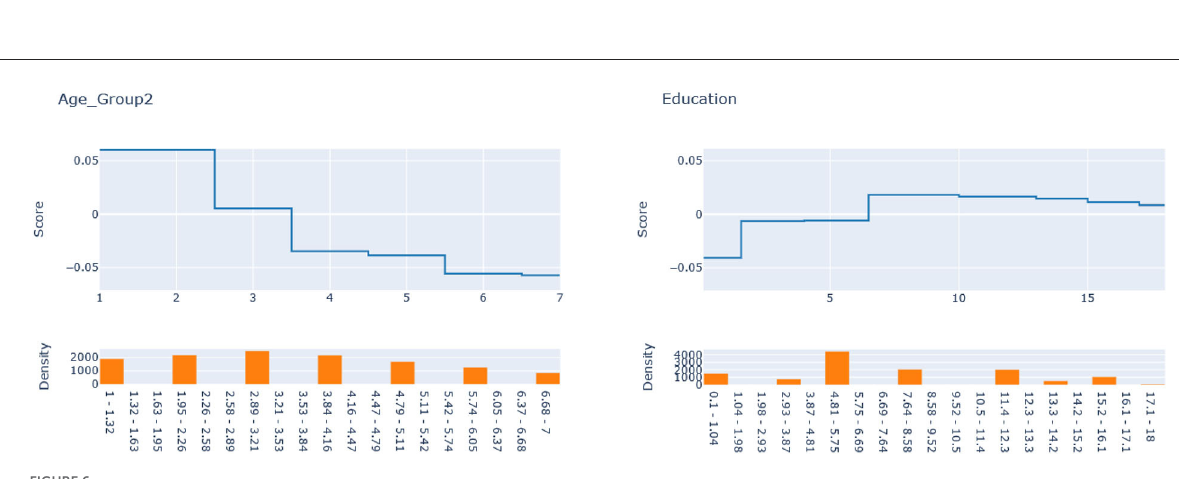
FIGURE6 Explainable boosting machine (EBM) additive terms for Age and Education explain the IHD ln ˆ OR